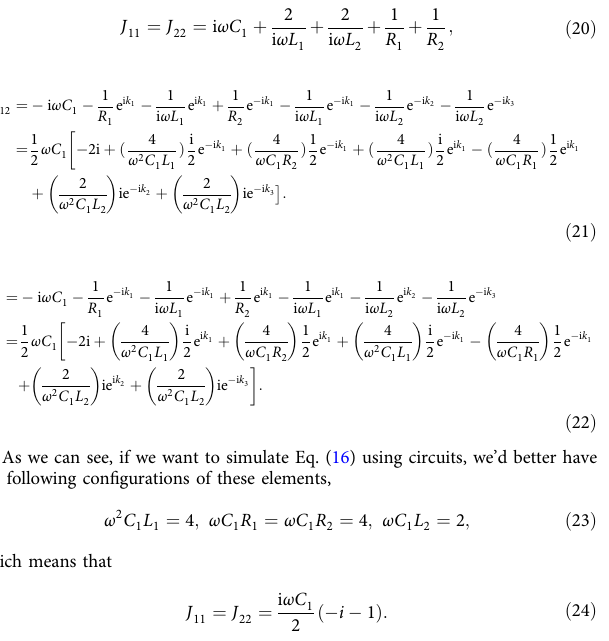
Trefoil knot — a (2,3)-torus knot Non-Hermitian Trefoil knot circuits . Similar to the non-Hermitian Hopf-link cir-